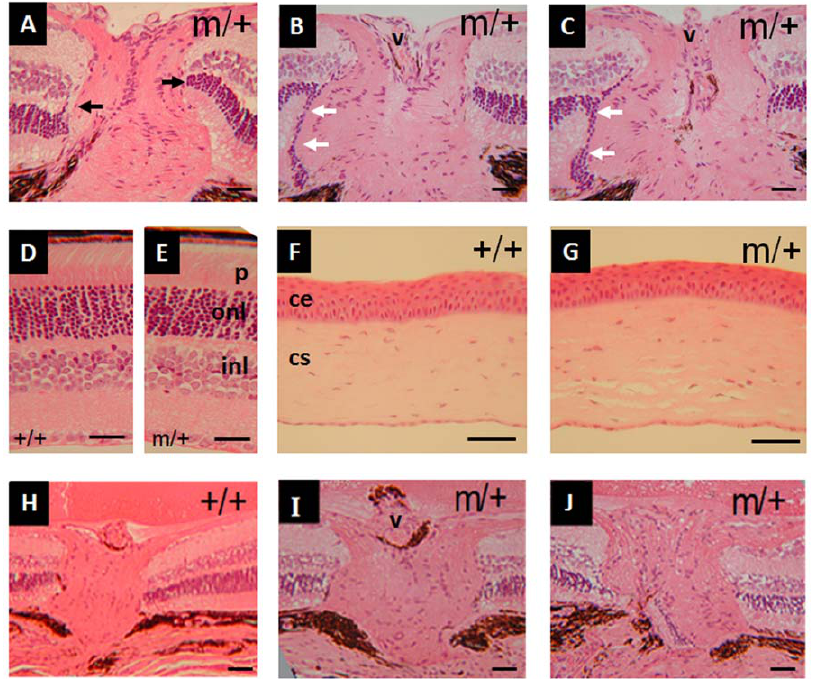
Figure 5. Representative images of eye phenotype of aged heterozygous Foxf2 W174R mutant mice. A , 6 month old Foxf2 W174R eye (m + /) showing normal retinal termination at the edge of the optic nerve fibre layer (black arrows). B&C, sections through two other 6 month old Foxf2 W174R eyes showing abnormal bulge in the nerve fibre layer. The outer nuclear layer of the retina can be seen to continue at the surface of this bulging tissue (white arrows). D&E , retinal sections in 6 month eyes. F&G , corneal sections in 6 month eyes. H–J , 12 month Foxf2 W174R optic nerves that do not show signs of glaucomatous change. v, vein; p, photoreceptors; onl, outer nuclear layer; inl, inner nuclear layer; ce, corneal epithelium; cs, corneal stroma. Scale bar =50 m m.